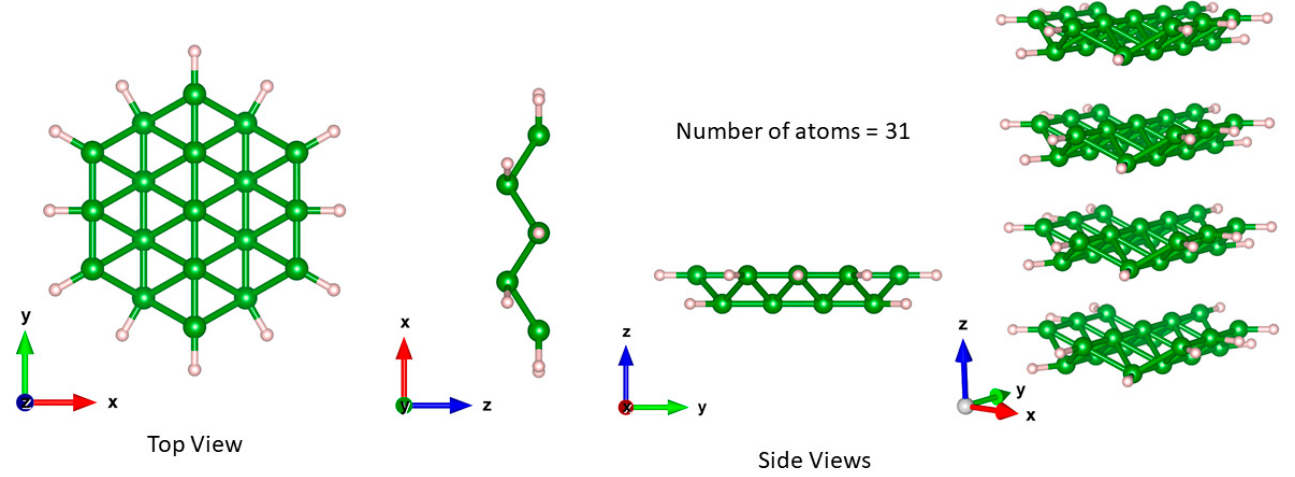
Figure 4. The top and side views of the borophene monolayer nanoflake and tilted side view of the borophene quad-layer nanoflake. Green (pink) balls represent B and H atoms.